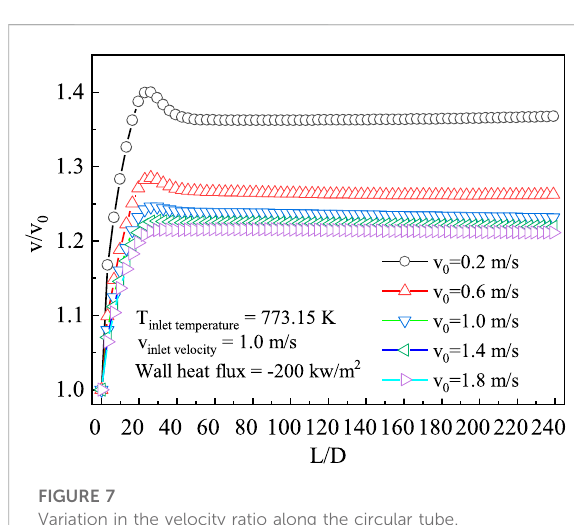
FIGURE 7 Variation in the velocity ratio along the circular